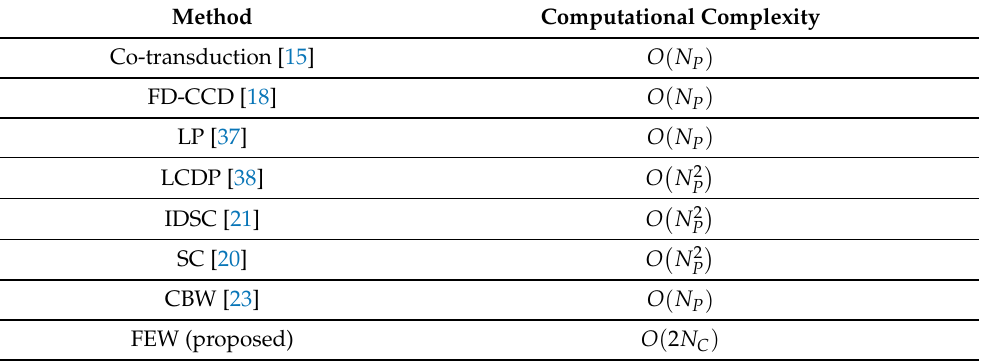
Table 1. Some representative shape recognition methods feature computational